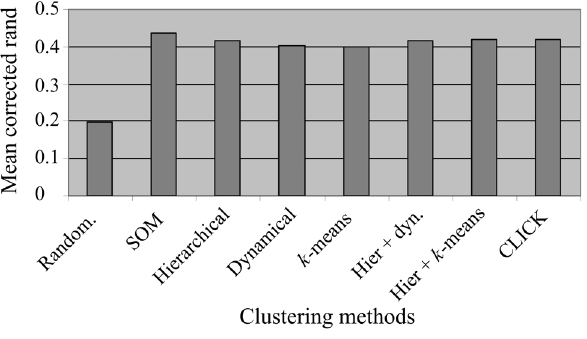
Figure 4 - Mean of corrected Rand values from the Series CDC 25 experi-